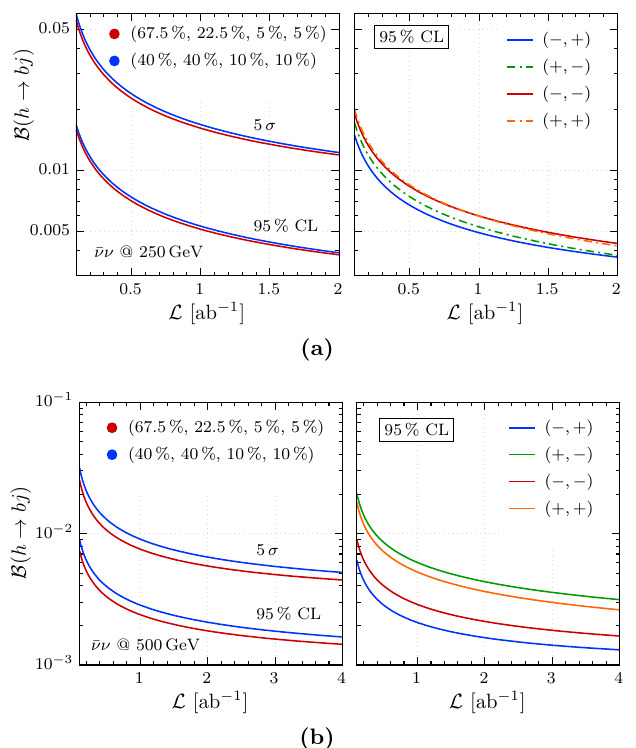
Figure 5. (a) Left : expected 95 % CL exclusion and 5 (cid:27) discovery reaches on neutrino channel at p s = 250 GeV as a function of the total integrated luminosity for the two polarisation scenarios described in the text. (a) Right : expected exclusion reaches for the four possible polarisation con(cid:12)gurations individually. Both plots assume (cid:15) syst = 1 %. (b) : same as (a) but for p s = 500